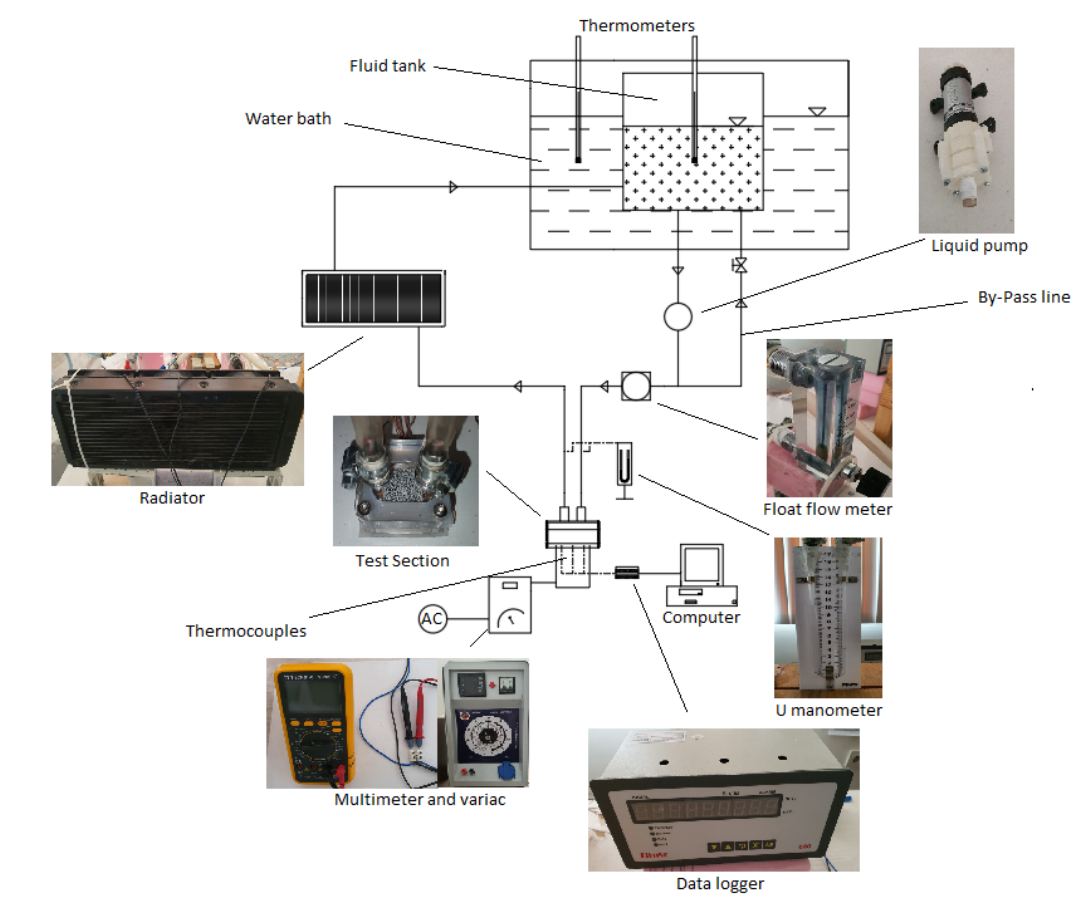
Figure 1. Schematic diagram of experimental setup.